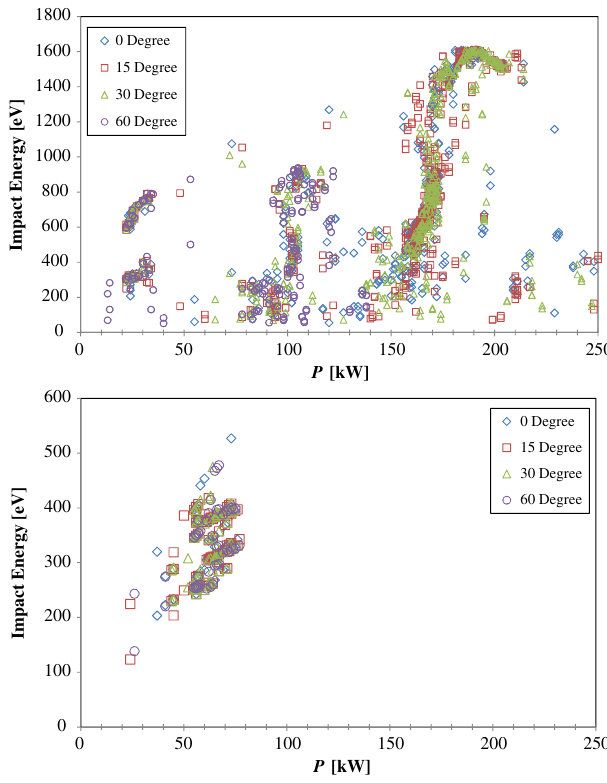
FIG. 11. Multipacting in the coupler at different reflection phases:top